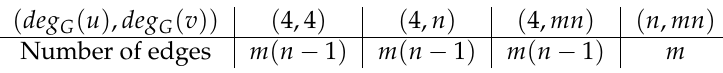
Table 2. Edge partition of Basava wheel windmill W